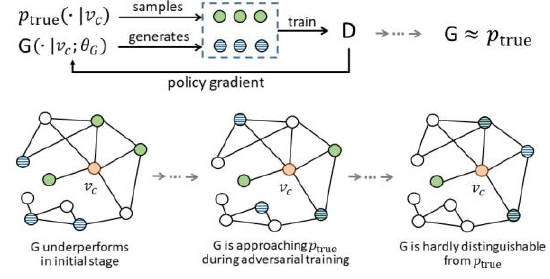
Figure 2. The mechanism of the GraphGAN （ by courtesy of Hongwei Wang, etc.. ）